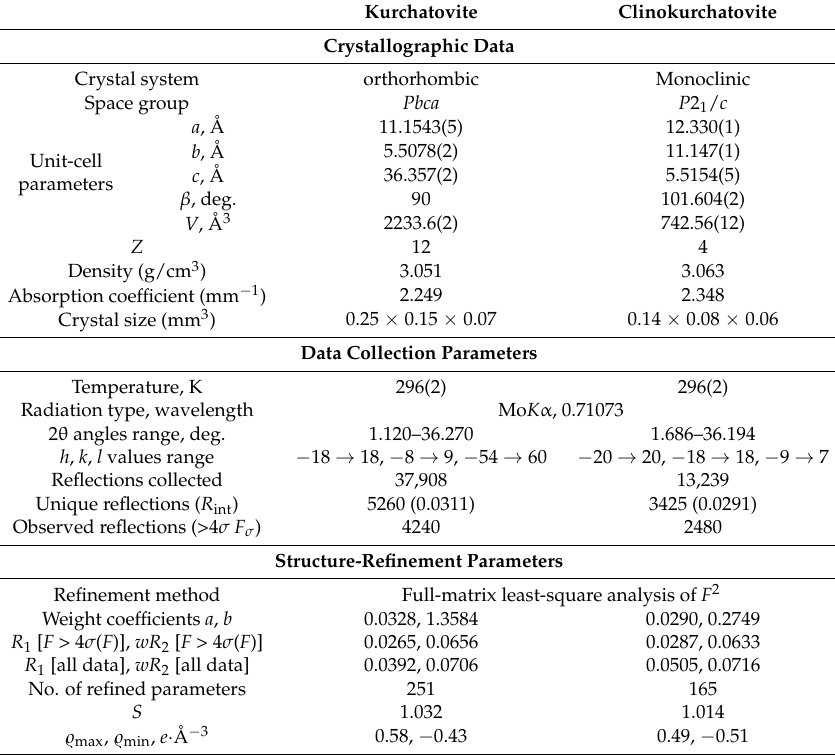
Table 2. Crystal data and structure refinement for kurchatovite and clinokurchatovite.